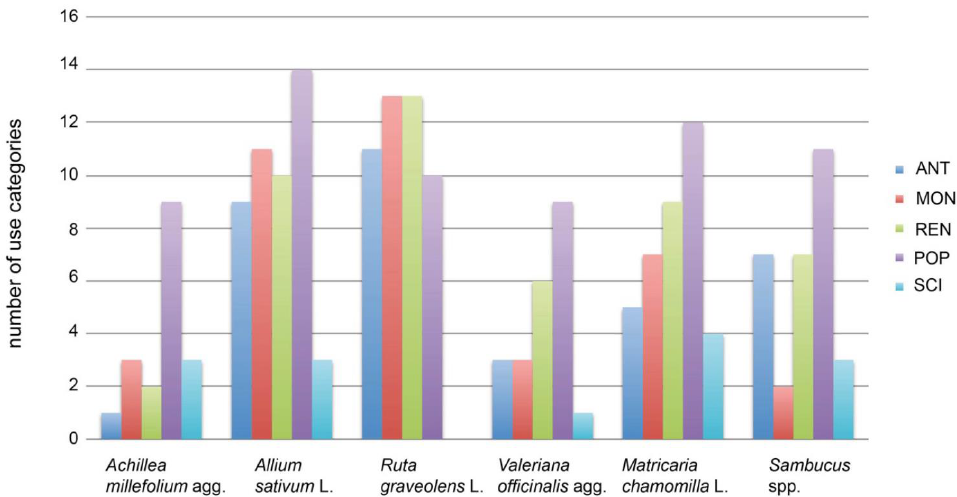
Figure 3. Number of use categories for 6 species during different eras, showing different diachronic trends.